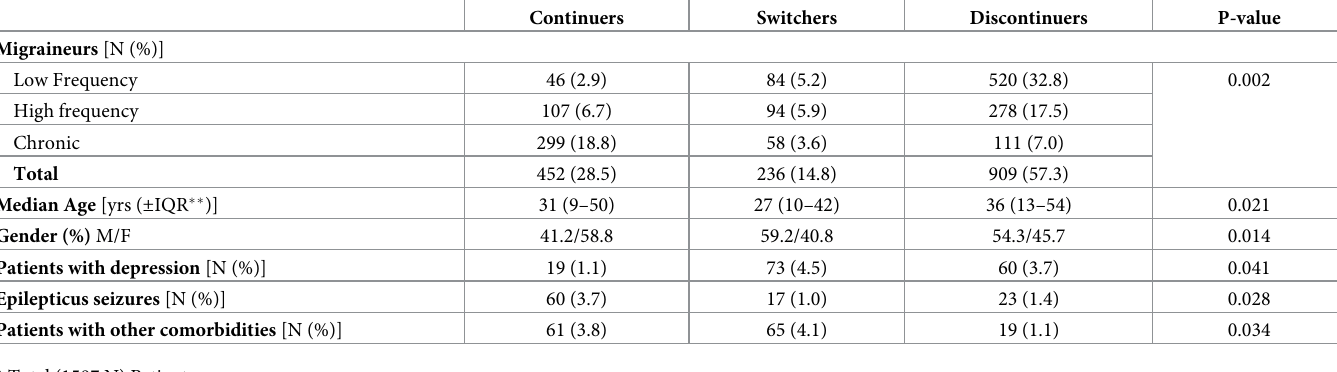
Table 3. Demographics and characteristics data by persistence patterns of